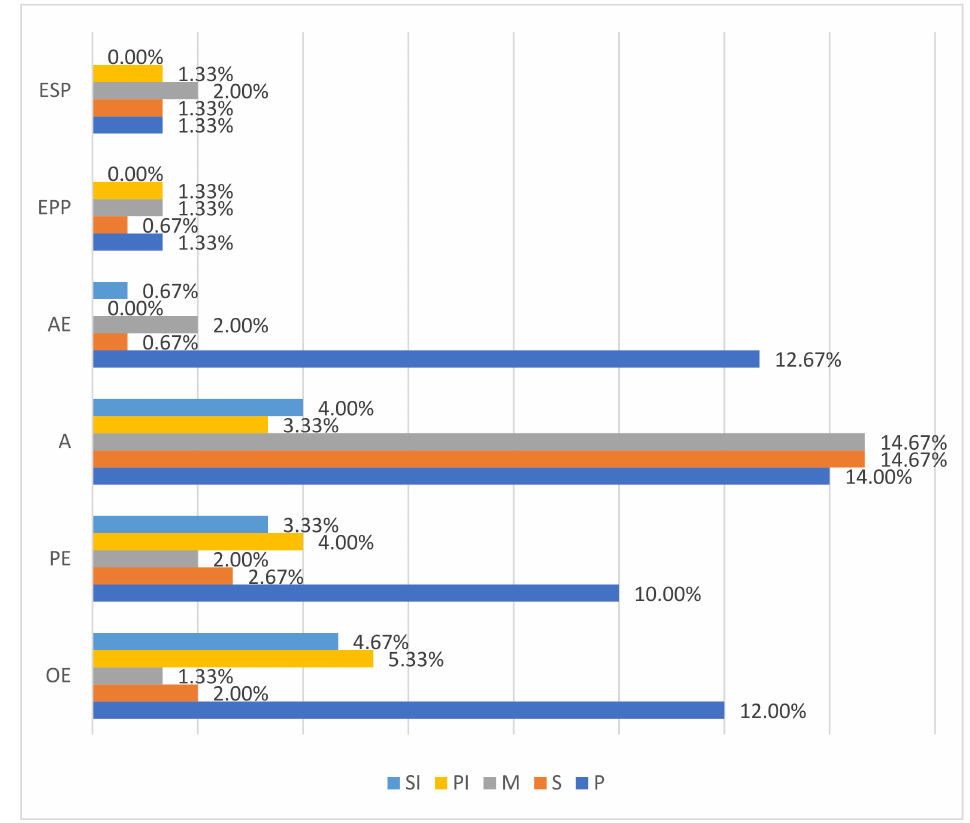
Scheme 1. Proportion of symptomatic patients depending on the location of endometriosis. OE = Ovarian endometriosis, PE = Peritoneal/pelvic endometriosis, A = Adenomyosis, AE =